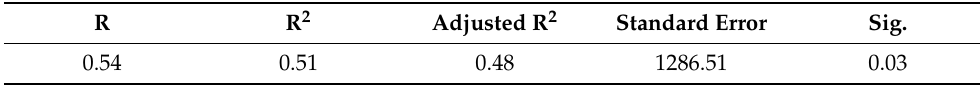
Table 5. Summary of models for residential